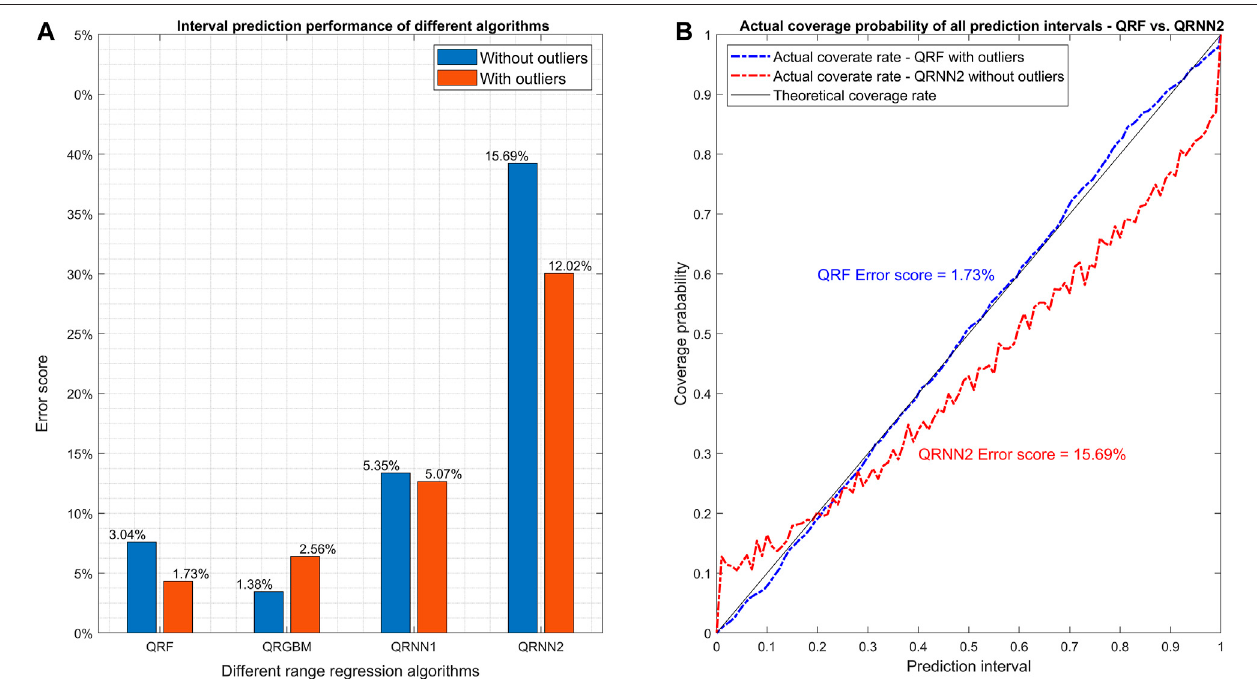
FIGURE4| ComparisonofdifferentrangeregressionalgorithmsbasedonES.Plot (A) showstheerrorscoreinthe fi naltestingstepforthevariousalgorithmsafter model tuning. Plots (B) and c show the actual coverage rates for all the prediction intervals of the best (QRF) and worst algorithm (QRNN2). The number after QRNN indicates the number ofhidden layers in the quantile regression neural networks. All the models were trained both with and without the outliers(outside95% con fi dence interval) in the original dataset fi ltered to check if the algorithms can handle outliers.